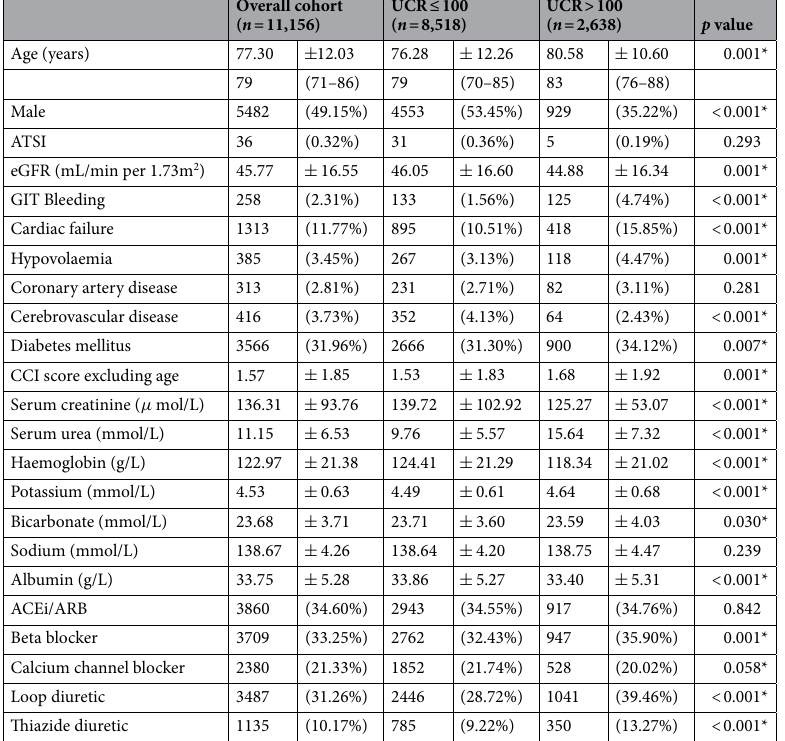
Table 1. Baseline characteristics of the study population. UCR Urea-to-Creatinine Ration; ATSI Aboriginal or Torres Strait Islander; eGFR Estimated Glomerular Filtration Rate; GIT Gastrointestinal Tract; CCI Charlson Comorbidity Index; ACEi Angiotensin-Converting Enzyme Inhibitor; ARB Angiotensin II Receptor Blocker; * Patient characteristics with a p value < 0.05 are significantly different between patient